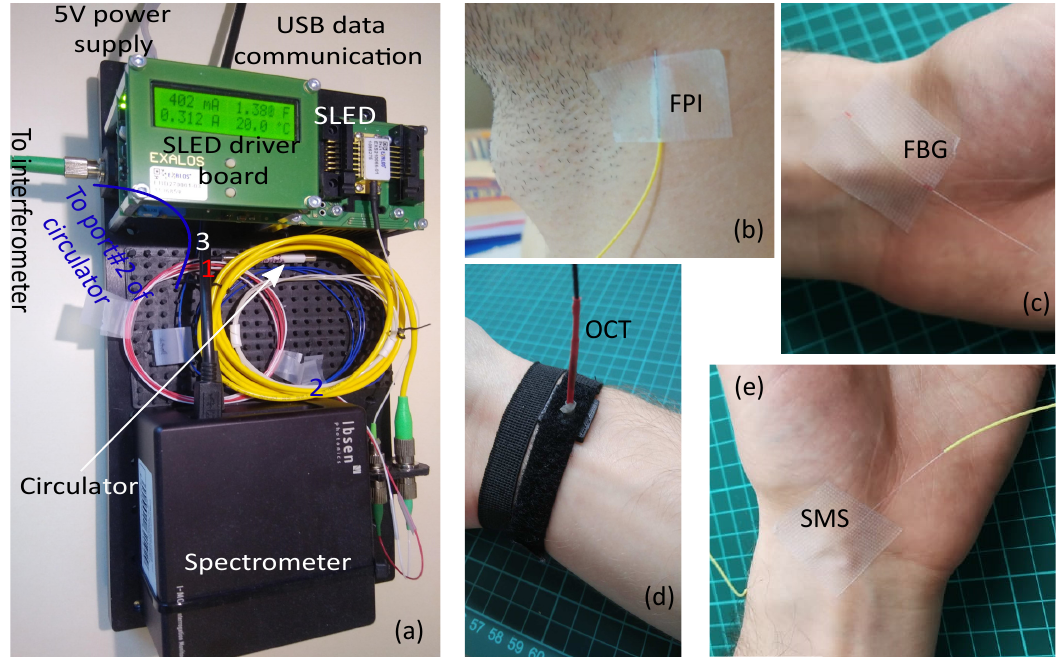
Figure 1. Photo of interrogation setup ( a ) and examples of FPI ( b ), FBG ( c ), OCT ( d ) and SMS ( e ) pulse wave sensors fixed over subject’s artery. ( a , b ) are reproduced from